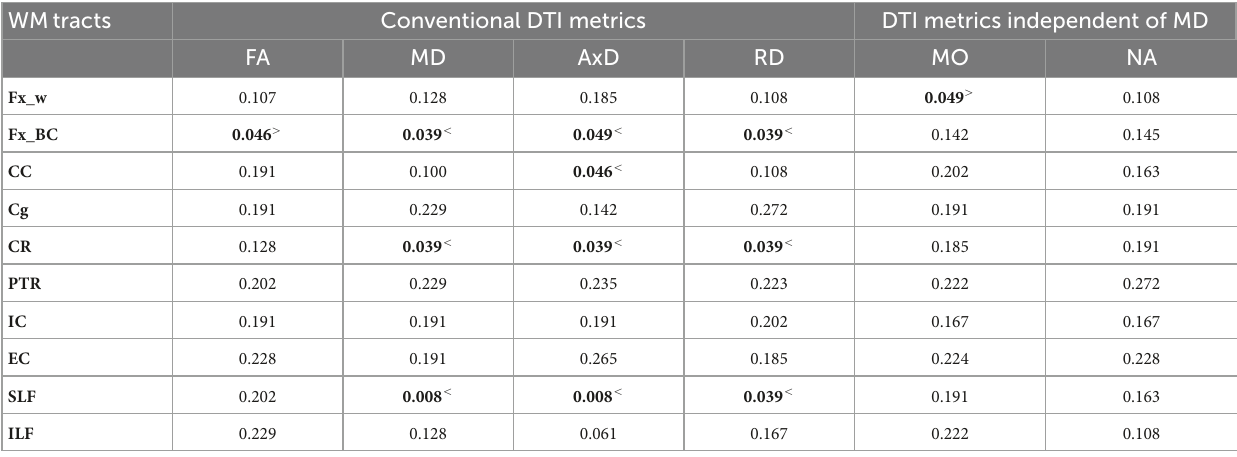
TABLE 2 Summary of statistical significance of the group comparisons among DTI metrics in various white matter tracts between APOE4 carrier (APOE4+) and non-carrier (APOE4 − )